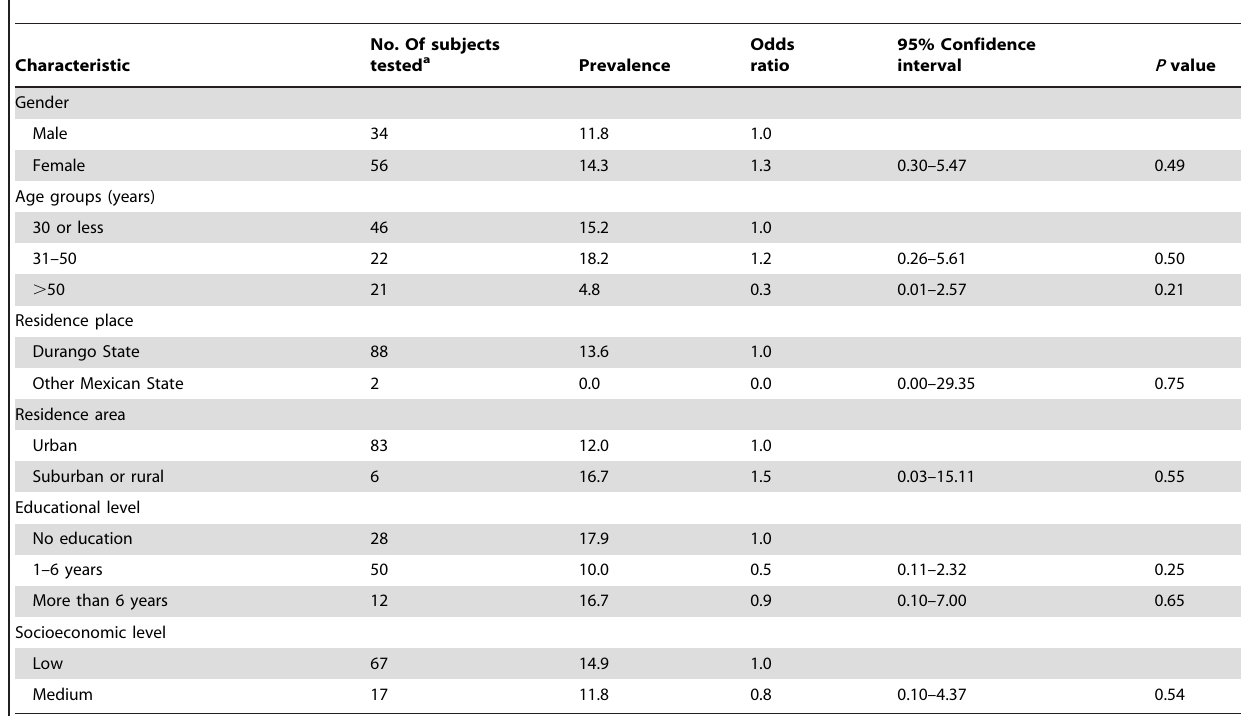
Table 1. Seroprevalence (%) of toxocaral infection in waste pickers relative to bivariate analysis of sociodemographic variables.